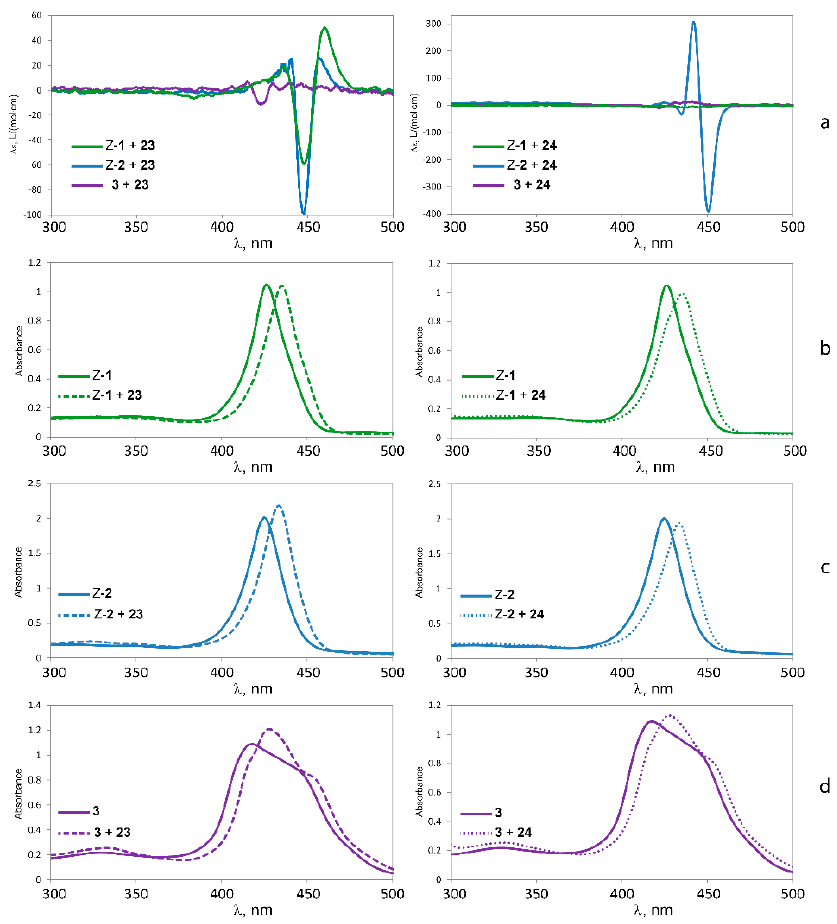
Figure 12. CD spectra ( a ) and UV-Vis spectra of L -lysine methylester 23 ( left ) and L -tryptophan methylester 24 ( right ) bound to tweezers 1 ( b ); 2 ( c ) and 3 ( d ).